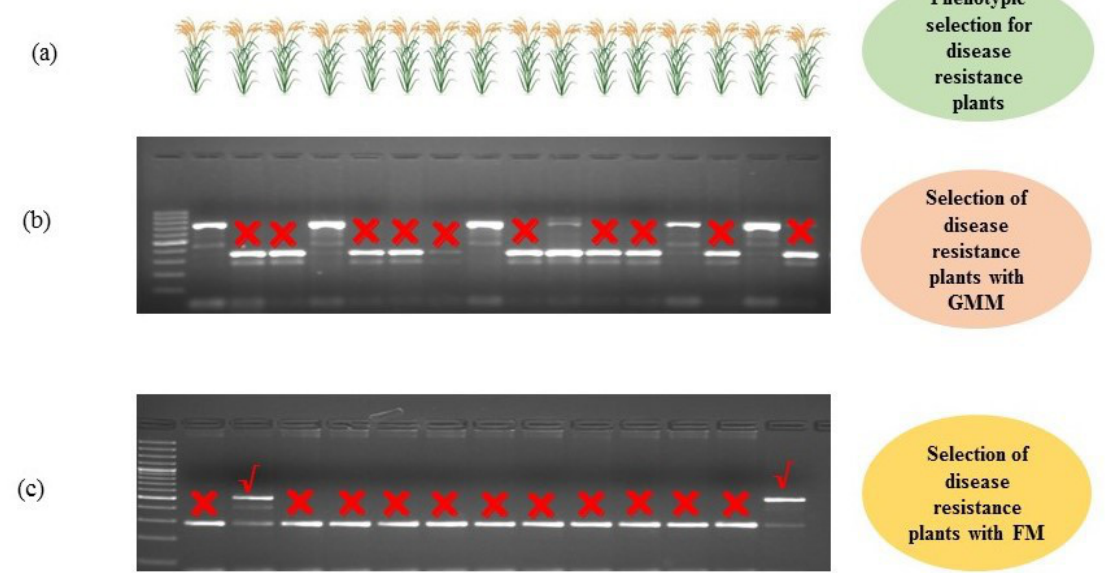
Figure 4. Use of functional markers (FMs) in marker assisted selection in precision breeding. ( a ) Phenotypic selection for disease resistance plants. ( b ) Selection of disease resistance using genic molecular markers (GMM). ( c ) Disease resistance plants selection using functional marker (FM).